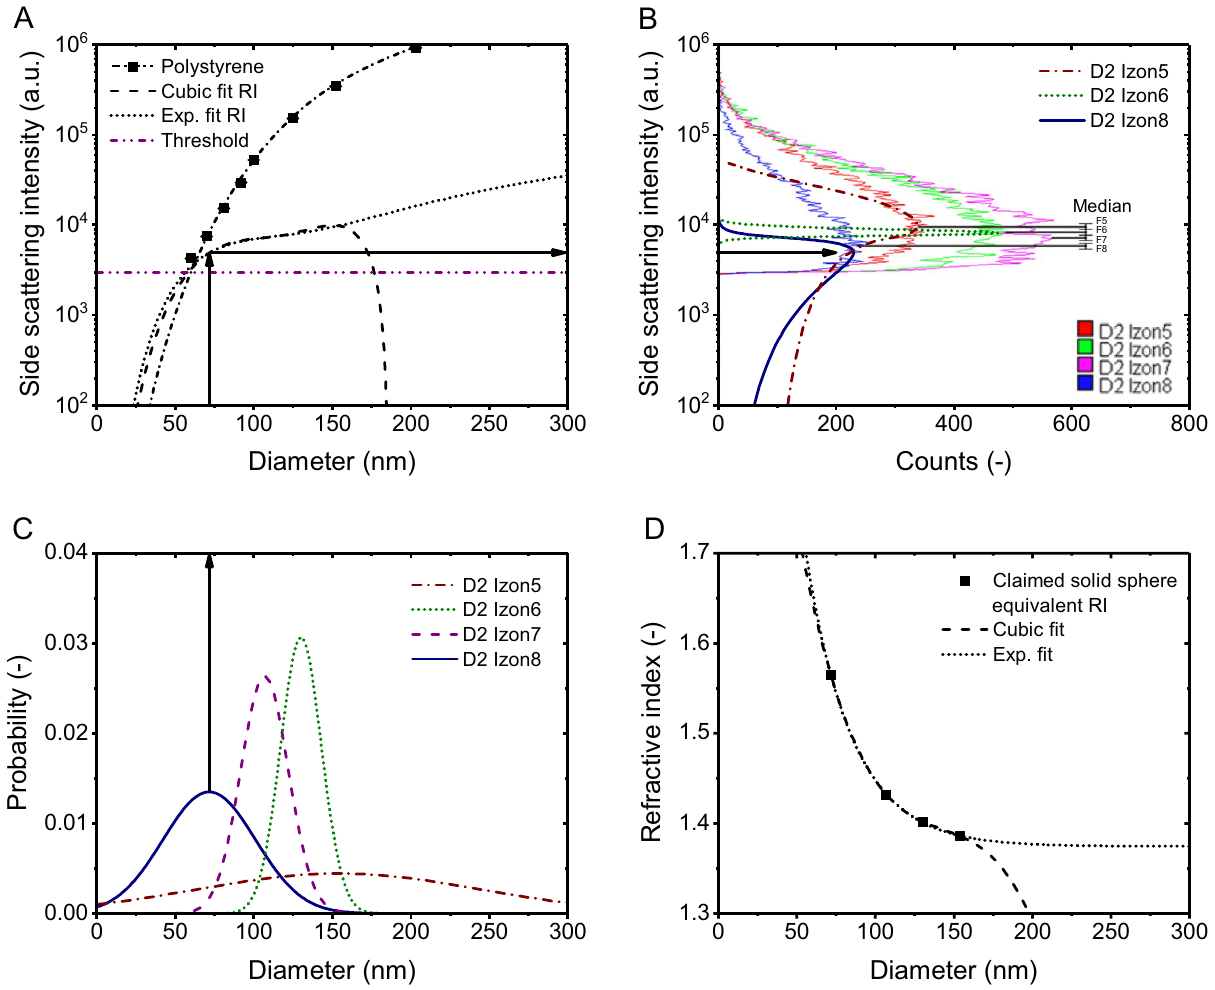
3000.000.010.020.030.04 Figure 2. ( A ) Side scattering intensity measured (symbols) by a CytoFLEX 1 and calculated (lines) by Mie theory 10 versus diameter for polystyrene beads (squares). The assumed refractive index (RI) is 1.627 for polystyrene beads. EVs were modelled as particles with the diameter dependent solid particle equivalent RIs shown in panel D. The horizontal line indicates the trigger threshold. ( B ) Side scattering intensity of CD61 + EVs from fractionated plasma versus counts measured (light lines) by the CytoFLEX 1 and predicted (dark lines) based on the measured size distribution in ( C ) and the scatter to diameter relation in ( A ) (black arrows). Colors indicate size exclusion chromatography fractions 5 (red and dash-dotted brown), 6 (green and dotted dark green), 7 (purple) and 8 (blue and solid dark blue). Fraction 7 resulted in a similar side scattering distribution as fraction 6 and is left out for clarity. Predictions do not describe the data. (C) Size distribution of particles from the same fractionated plasma as in panel B measured by dynamic light scattering (DLS; µ Izon5 = 153.82 nm, PDI Izon5 = 0.34, σ Izon5 = 89.7 nm, µ Izon6 = 130.17 nm, PDI Izon6 = 0.01, σ Izon6 = 13.0 nm, µ Izon7 = 106.99 nm, PDI Izon7 = 0.02, σ Izon7 = 15.1 nm, µ Izon8 = 71.66 nm, PDI Izon8 = 0.17, σ Izon8 = 29.5 nm). ( D ) Refractive index versus solid particle equivalent diameter claimed by Brittain et al. (symbols) fitted with a cubic function (y 0 =